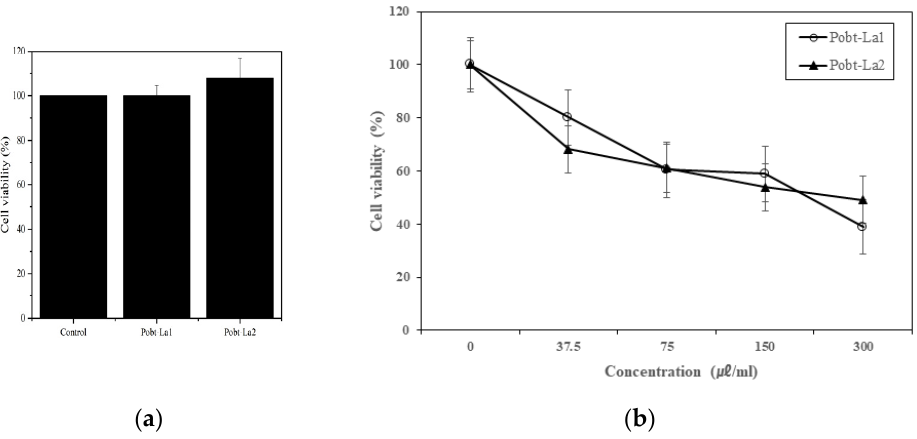
Figure 1. WST-1 assay for cell viability. ( a ) CCD-18Co and ( b ) HT-29 cells.